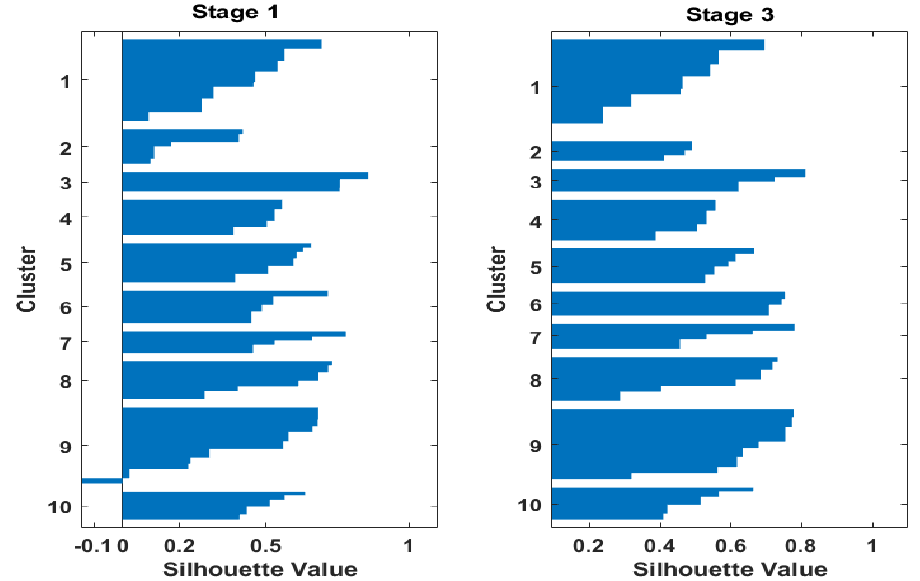
Figure 6. Silhouette plots 10 clusters for 25,307 audiograms stage 1 and 22,002 audiograms for stage 3. Table 5. Different clustering evaluation criteria for audiograms population.